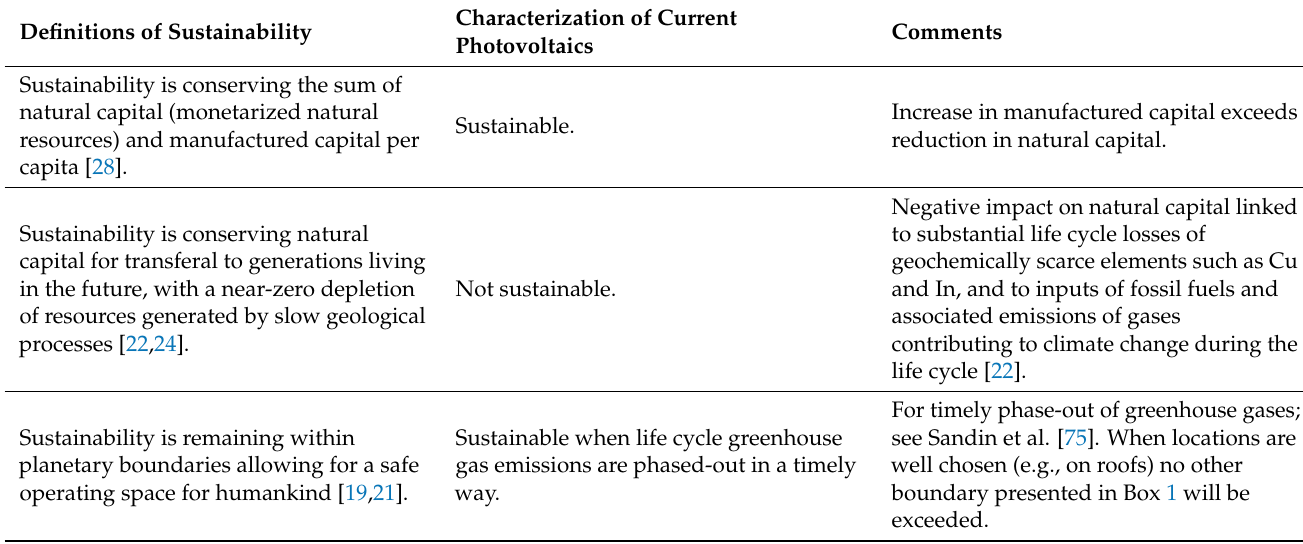
Table 4. The sustainability of current photovoltaics using three definitions of